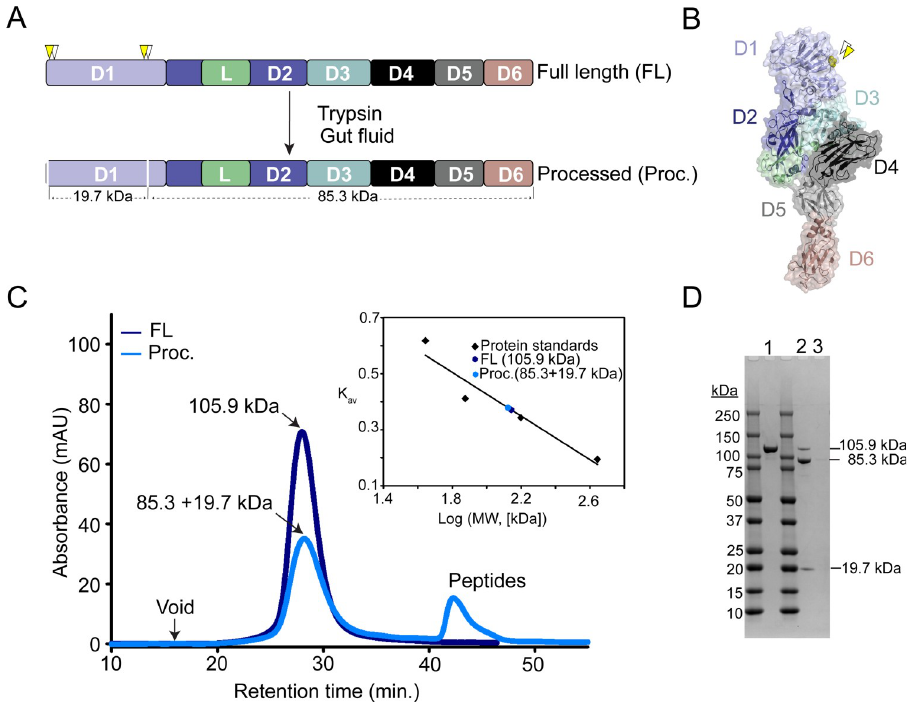
Fig 4. Vpb4Da2 processing by proteases occurs within domain 1. (A) Schematic representation of Vpb4Da2 domains and protease cleavage sites. Yellow and white arrowheads are gut fluid and trypsin cleavage sites, respectively. Cleavage sites at the amino terminal end, within domain 1 are indicated by clear vertical lines. (B) Surface rendition of Vpb4Da2 structure showing proteolytic cleavage sites (yellow spheres). (C) Analytical size-exclusion chromatography (SEC) profiles of the full-length (dark blue trace) and the trypsin-processed (light blue trace) Vpb4Da2. Full-length (105.9 kDa) and processed (85.3 kDa and 19.7 kDa complex) protein samples exhibit approximately the same retention time when ran separately through an SEC column. The calibration curve is shown in the inset and the experimentally determined molecular weights of full-length and processed Vpb4Da2 are indicted by dark blue and light blue squares, respectively. (D) The SDS-PAGE profile of the elution peaks from the full-length Vpb4Da2 (lane 1) and processed (lane 2) samples, along with the molecular size of the eluted protein bands, are shown. The SDS-PAGE profile of the elution peak at approximately 42 min designated “Peptides” in (C) and derived from processed Vpb4Da2 ran through the SEC column is shown in lane 3. No apparent peptides of molecular weights higher than 10 kDa were observed (lane 3), suggesting that peptides are very small breakdown products of the proteolytic